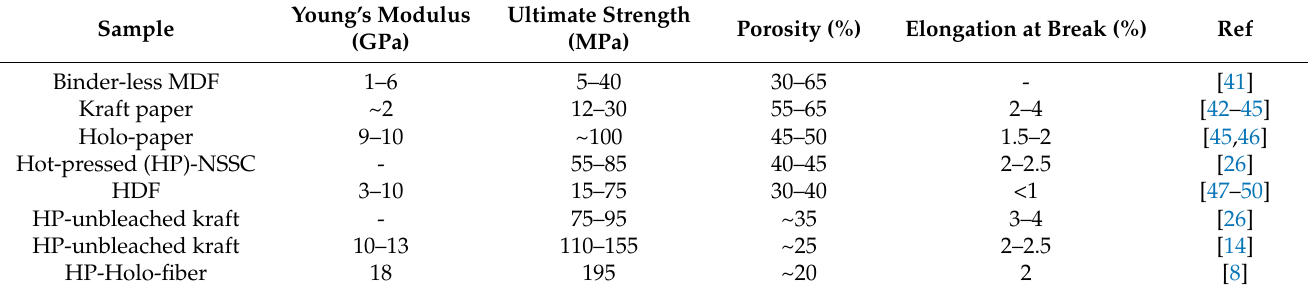
Table 1. Young’s modulus, ultimate strength, porosity, and elongation at break of 2D-random fiber materials.